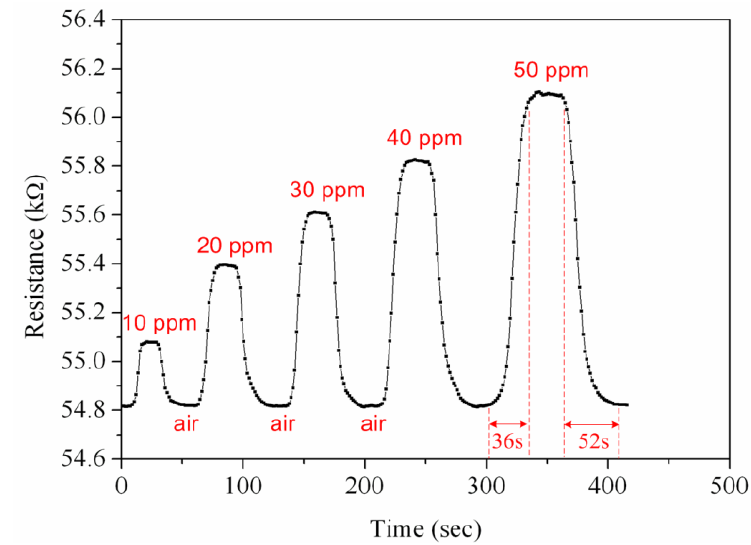
Figure 7. Test of the ammonia sensor.